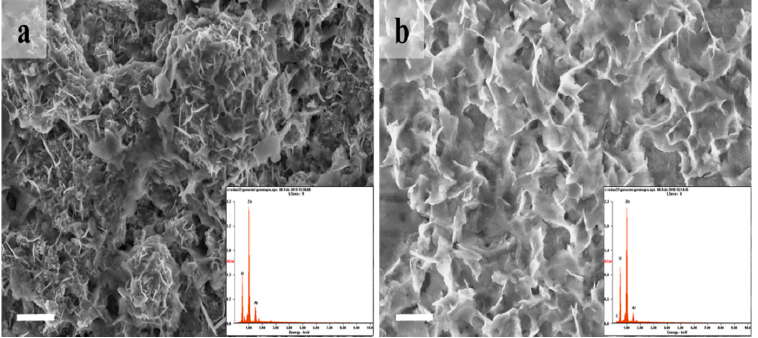
Figure 2. FE-SEM micrographs of ( a ) pristine LDH and ( b ) sample obtained at 300 °C calcination; scale bar of 1 μ m.